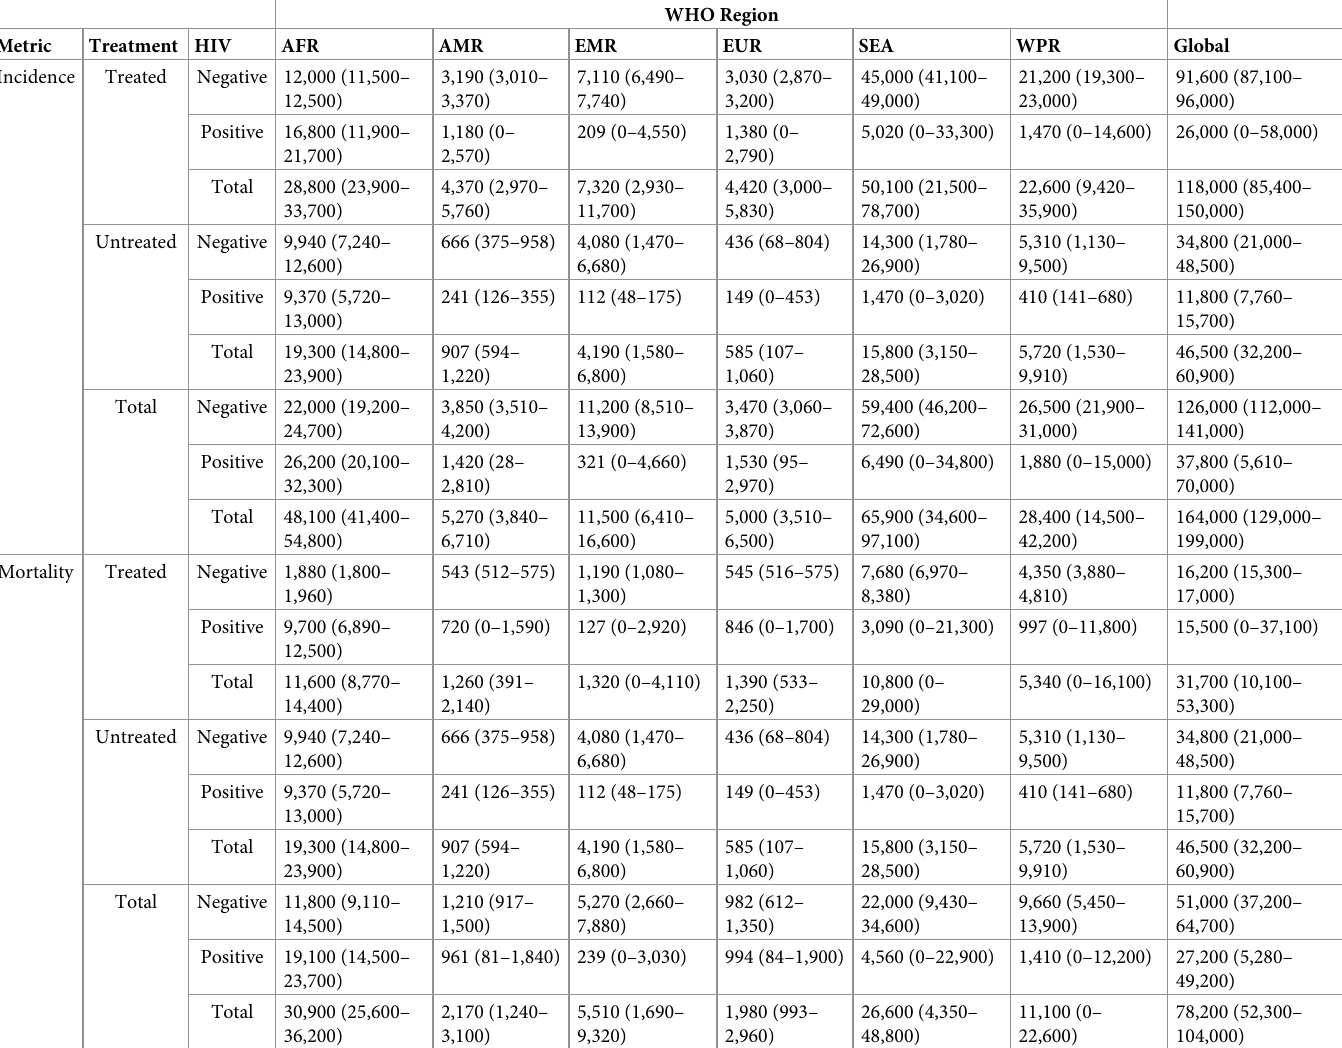
Table 2. Incidence and mortality of tuberculous meningitis, stratified by WHO region, HIV status and whether the patient received TBM treatment. WHO